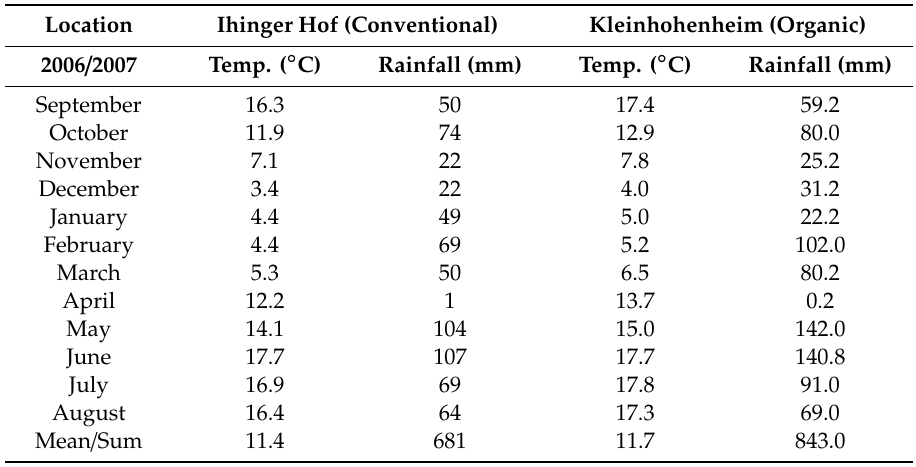
Table 1. Temperature and rainfall during the experimental seasons 2006–2007 and 2007–2008 at the locations Ihinger Hof, Renningen and Kleinhohenheim, Stuttgart, both in South-West